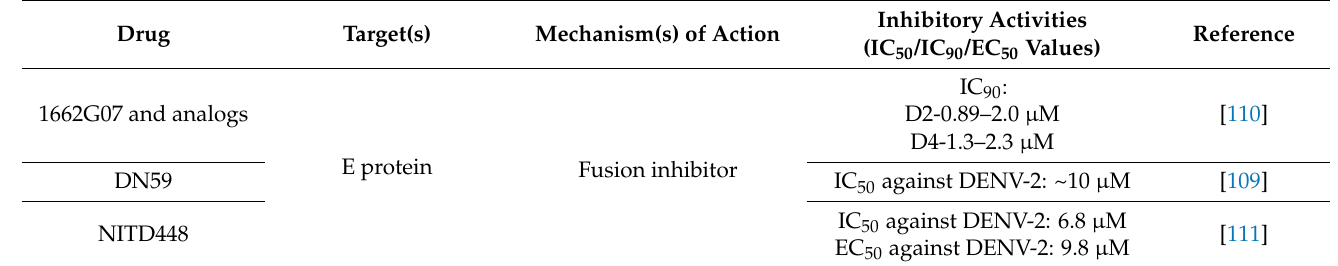
Table 3. Direct-acting antivirals of DENV targeting DENV structural